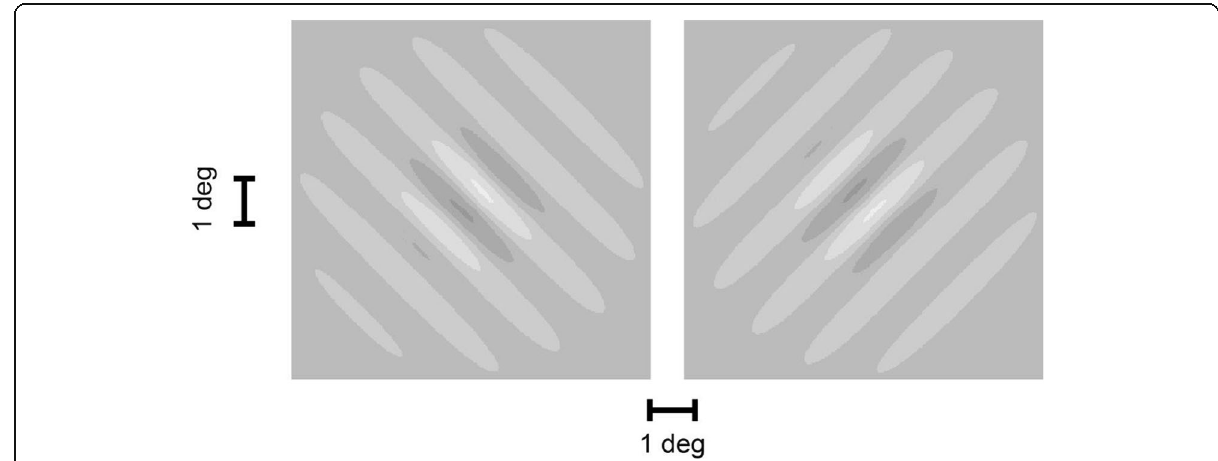
Fig. 1 Gabor patch that served as detection stimulus. The pattern was modulated in time by a harmonic sinusoidal modulation with amplitudes between 0.37 and 28 cd/m 2 and at six different frequencies (15 Hz, 20 Hz, 25 Hz, 30 Hz, 35 Hz and 40 Hz). Background luminance: 82 cd/m 2 . The figure shows the two alternative image orientations (leftward tilt/rightward tilt). The figures illustrate only the central portion of the screen (width: ±23.9 deg, height: ±14 deg). Outside of this window, the luminance was constant and equal to the background